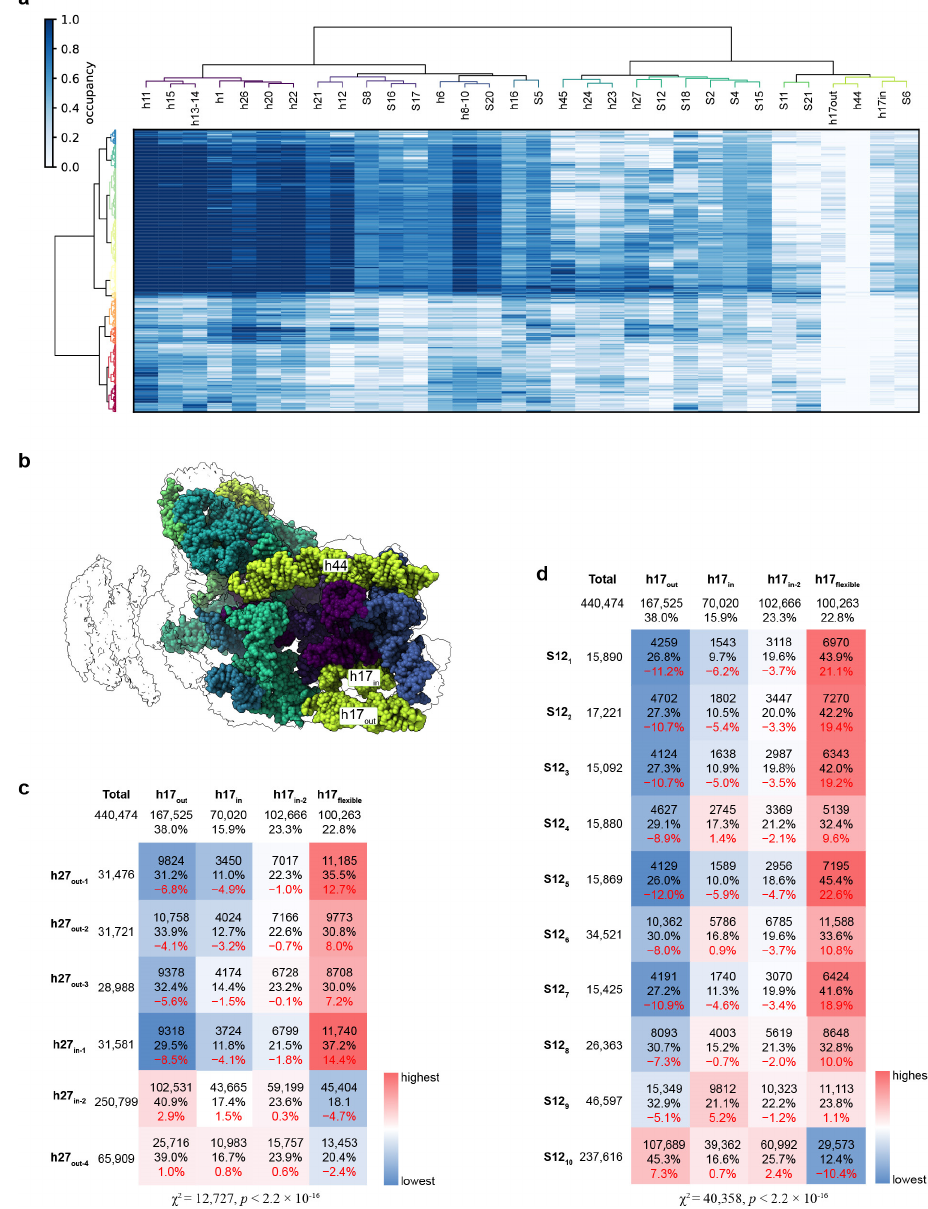
Figure 5. The movements of the different structural blocks are correlated. ( a ) Occupancy analysis of 30S 1mM particles displayed as a heatmap. Rows (500) correspond to sampled density maps, and col- umns (32) correspond to structural elements defined by the atomic model. Only the 30S body was analyzed. ( b ) Atomic models of the 30S subunit used for subunit occupancy analysis are colored according to the structural blocks defined through hierarchical clustering in (a). Structural features of interest are annotated. ( c ) Correlation between h17 and h27 in the reconstructions classified with different masks. The mask on h17 defined four different states of h17, and the mask on the decoding center defined six states of h27. Particles in each state were selected, and the distribution of particles in different h17 conformations was calculated. For each h27 state, the difference in distribution com- pared to the total particles is colored in red. ( d ) Same as ( c ), but the correlation between h17 and S12 was calculated. 3.7. Mg 2+ Is Essential for Ribosome Structure Stability To further investigate the effect of the Mg 2+ concentration on ribosome assembly, we performed sucrose gradient analysis with different levels of Mg 2+ (Figure 6). As observed at 1 mM Mg 2+ (Figure 2a), the 0.5 mM Mg 2+ condition also completely separated the 50S